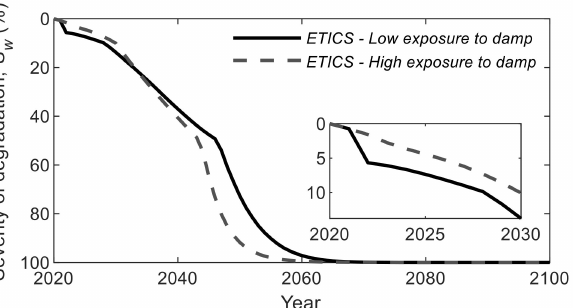
Figure 7. Comparison of the ETICS degradation curves without maintenance for low and high exposure to